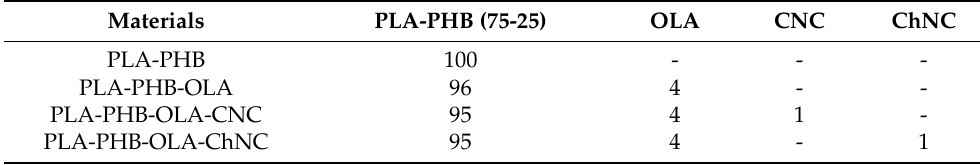
Table 1. Compositions of the biopolymer blends and nanocomposites are given in weight